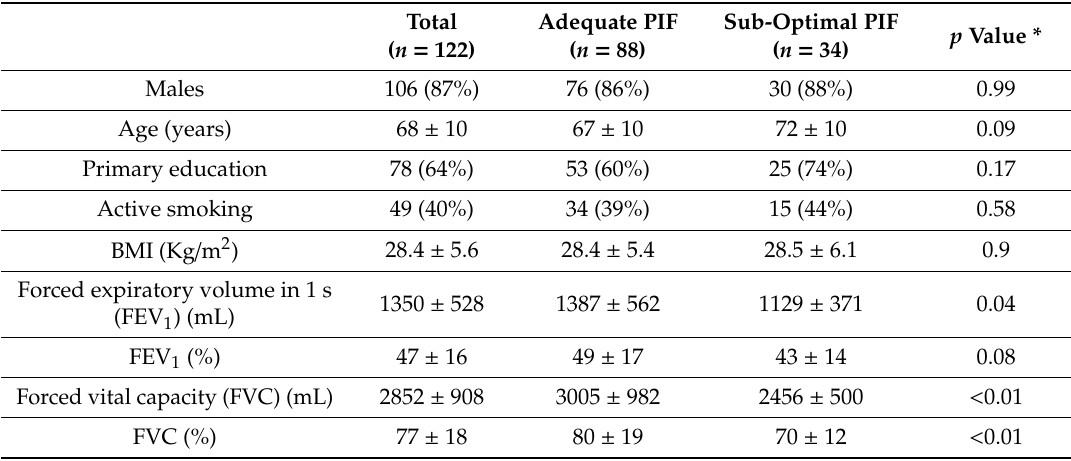
Table 1. Bivariate analysis of the sociodemographic, clinical, and functional variables that may predict suboptimal peak inspiratory flow.